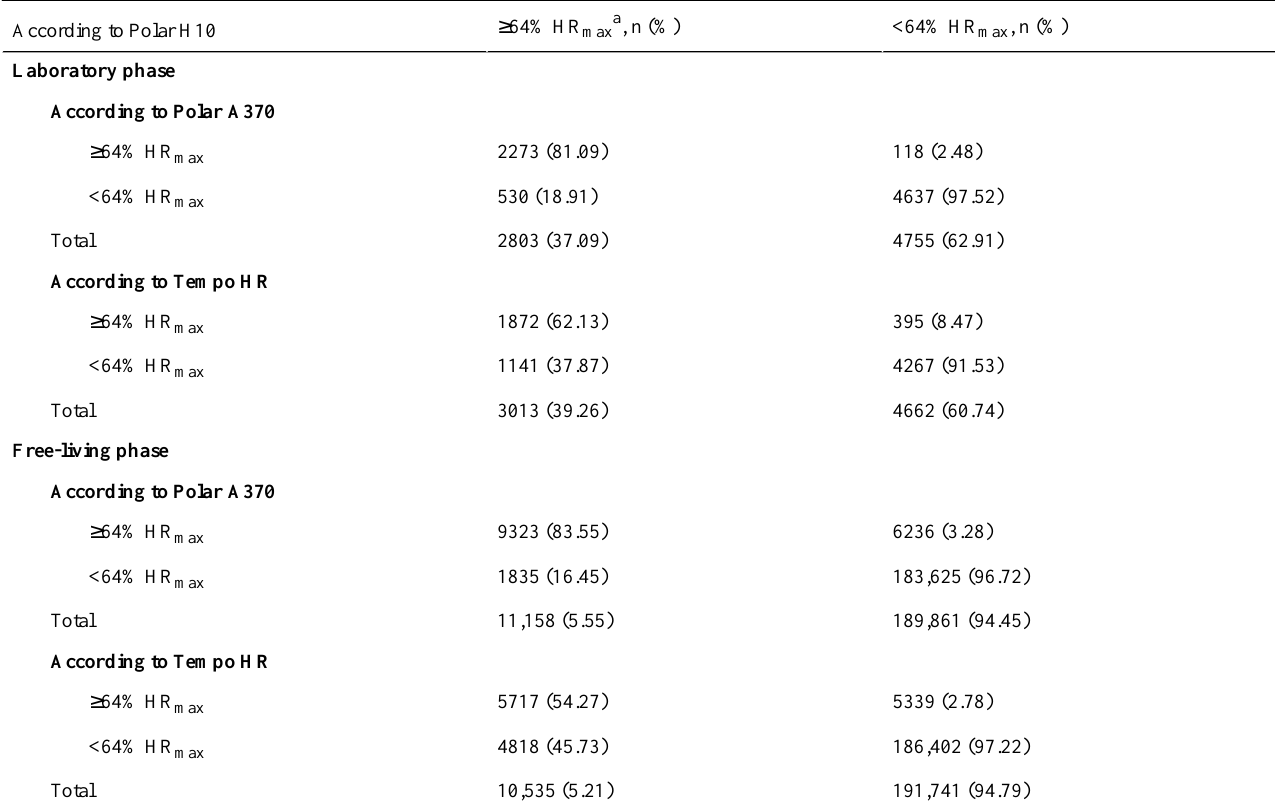
Table 1. Number of 10-second matched time points spent in heart rate zones as detected by the Polar A370 and the Tempo HR in the laboratory phase and free-living